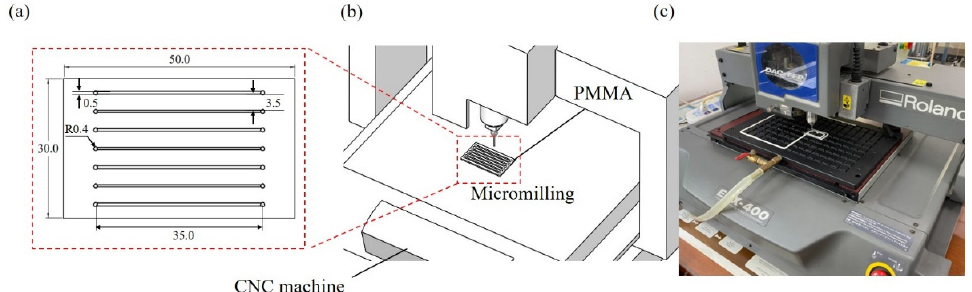
Figure 1. Microchannel fabrication by micromilling. ( a ) parallel microchannel design. ( b ) schematic of desktop router. ( c ) image of desktop router.